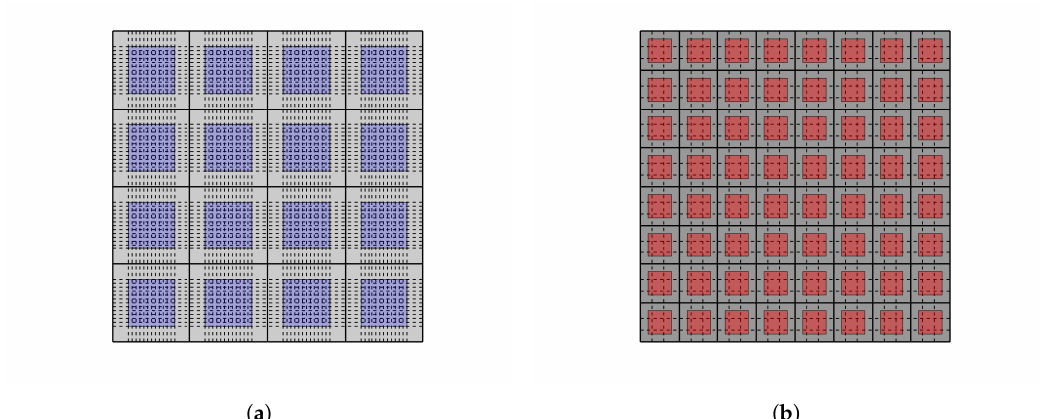
Figure 8. ( a ) Stimulated rock with low k f and high s . Density of the discrete macroscale fracture network is low and density of the microscale fractures (dotted lines) in the organic matrix is high. This situation results in a faster pressure decline in the organic matrix. Low permeability at the macroscale is compensated by higher permeability at the microscale. ( b ) Stimulated rock with high k f and low s . Density of the discrete macroscale fracture network is high and density of microscale fractures (dotted lines) in the organic matrix is low, causing a slower pressure decline in the organic matrix. Low permeability at the microscale is compensated by higher permeability at the